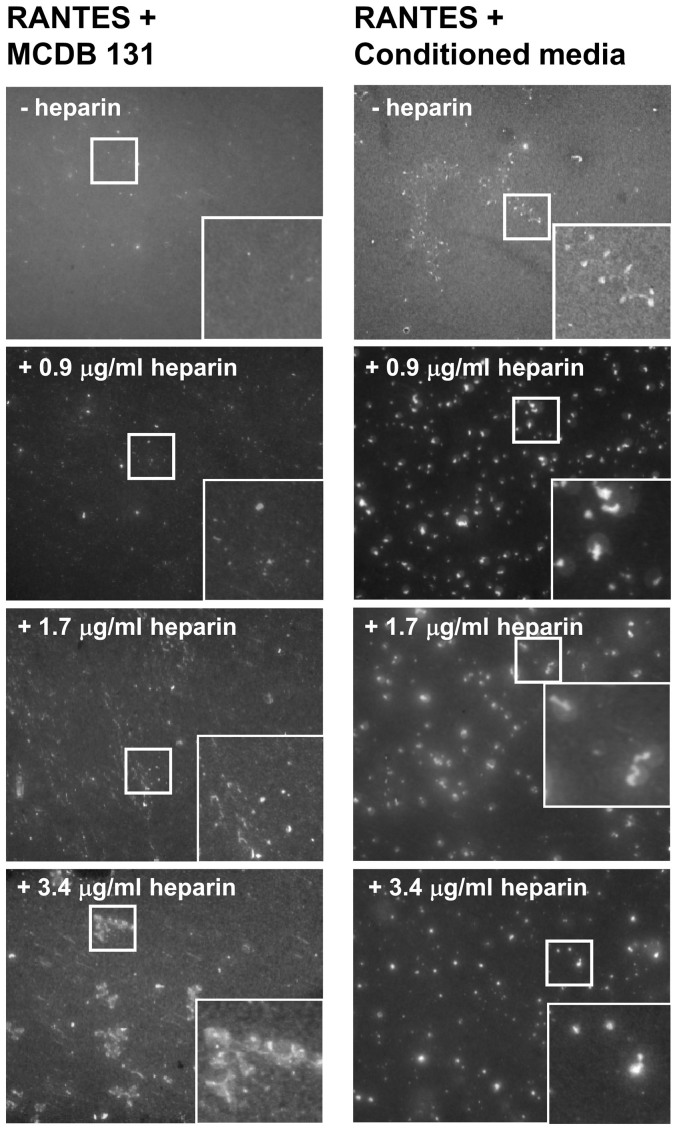
RANTES is dependent on other molecules to form organized structures.RANTES (1 μg/ml) was incubated either in cell growth medium
without serum or in conditioned cell growth medium containing serum. The
conditioned medium was harvested from unstimulated cultures of HUVECs.
Heparin was added and its final concentration is indicated in each image.
After 35 h, the samples were fixed and immunostained with a rabbit
antibody toward RANTES. The images were acquired by widefield microscopy.
Inserts show high magnification of squared areas. Scale bars,
10 μm.